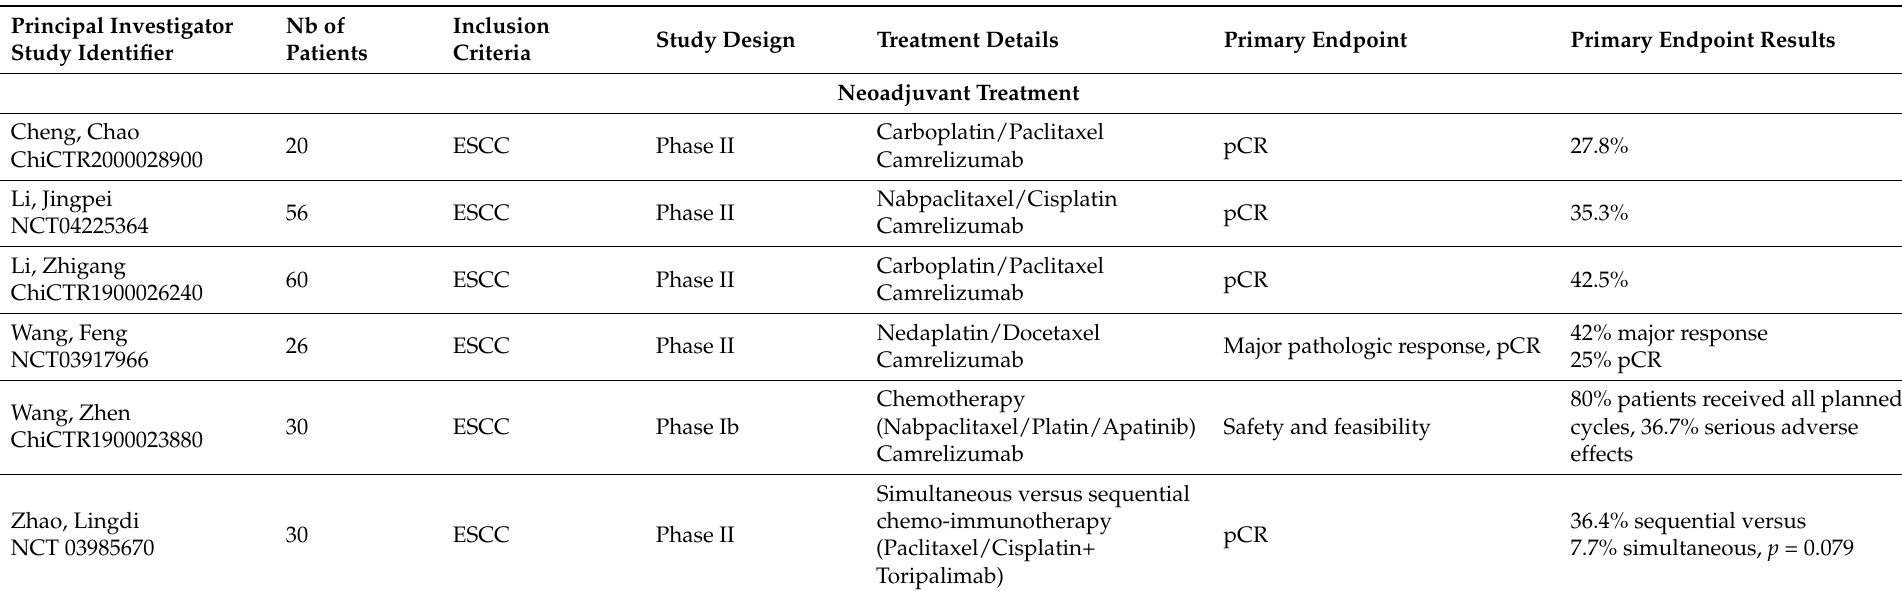
Table 3. Preliminary results